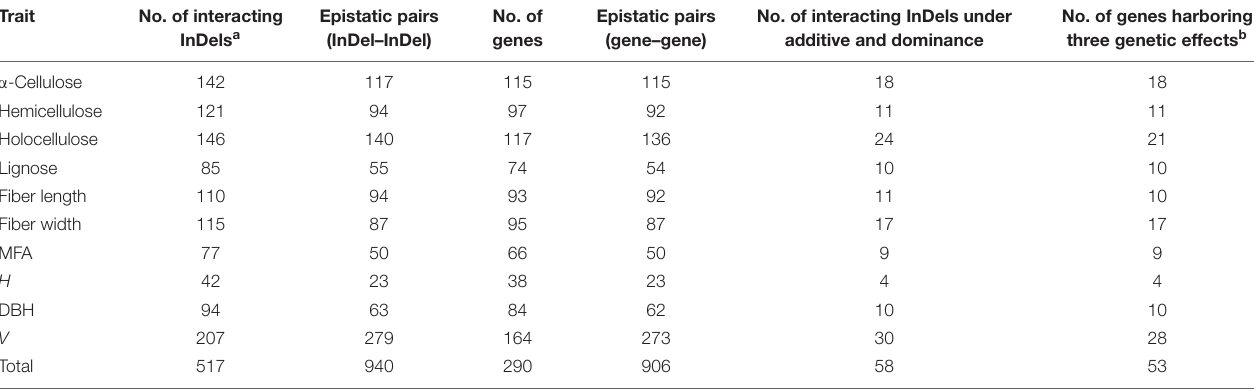
TABLE 3 | Summary of the additive, dominant, and epistatic effects of all significant InDels for each trait in P. tomentosa natural population. Trait No. of interacting Epistatic pairs No. of Epistatic pairs No. of interacting InDels under InDels a (InDel–InDel) genes (gene–gene) additive and